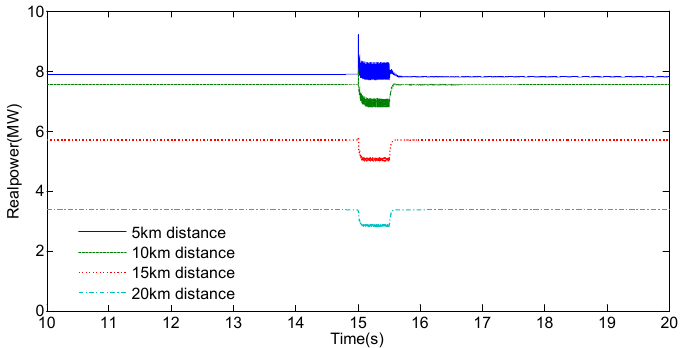
Figure 10. The active power of grid system under different connection distance between the grid source and the DFIG.